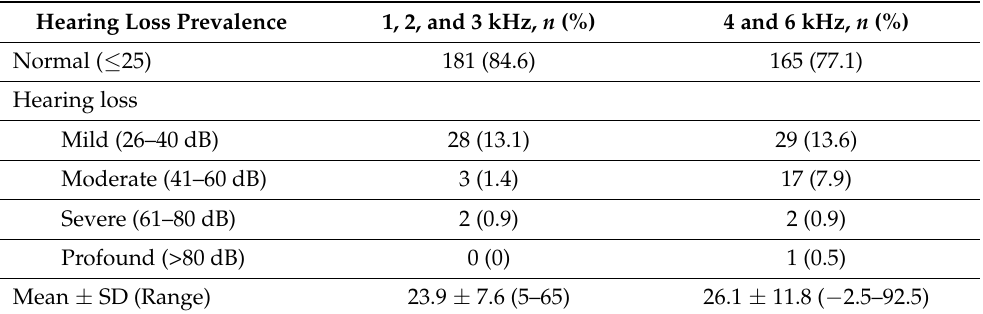
Table 5. Distribution of hearing loss, for the worst ear, at low (1, 2, and 3 kHz) and high (4 and 6 kHz)